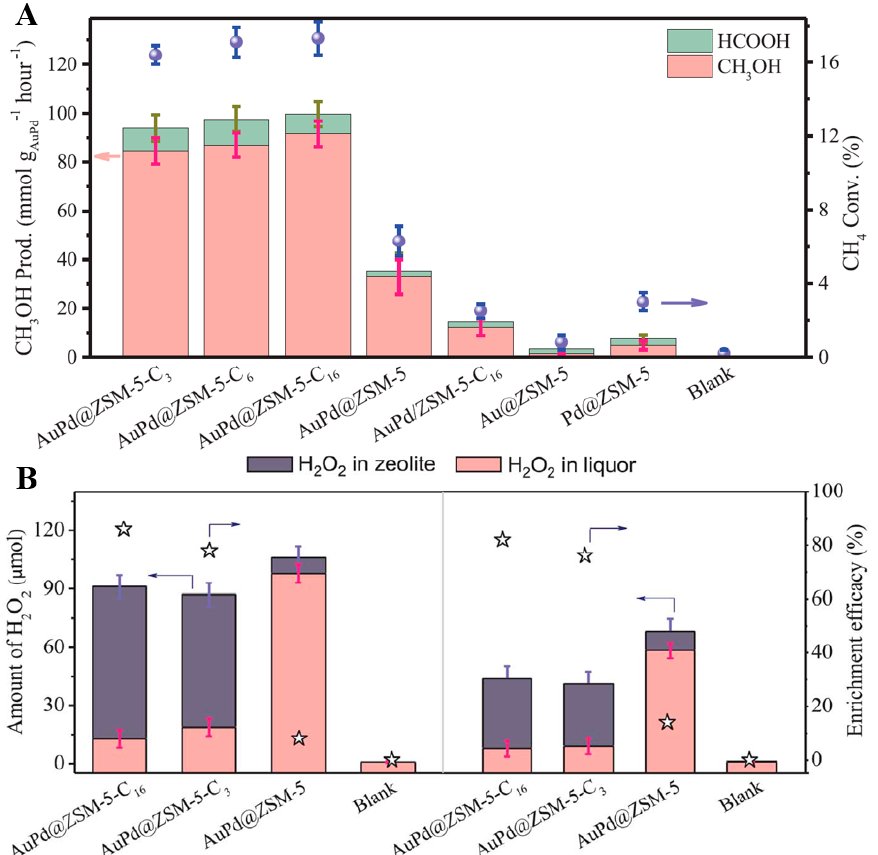
Figure 11. ( A ) Data characterizing the oxidation of CH 4 with H 2 and O 2 over various catalysts. ( B ) Data showing the amount of H 2 O 2 in the (left) H 2 O 2 synthesis and (right) CH 4 oxidation process. The enrichment efficacy is the percentage of H 2 O 2 in zeolite crystals to the total amount of H 2 O 2 in the reactor. Reaction conditions for CH 4 oxidation—10 mL of water, 30 min, 70 ◦ C, 27 mg of catalyst, 3.0 MPa of feed gas with 3.3% H 2 /6.6% O 2 /1.6% CH 4 /61.7% Ar/26.8% He, 15 min and 1200 rpm. Each reaction was tested eight times to obtain the error bars. Reproduced with permission from